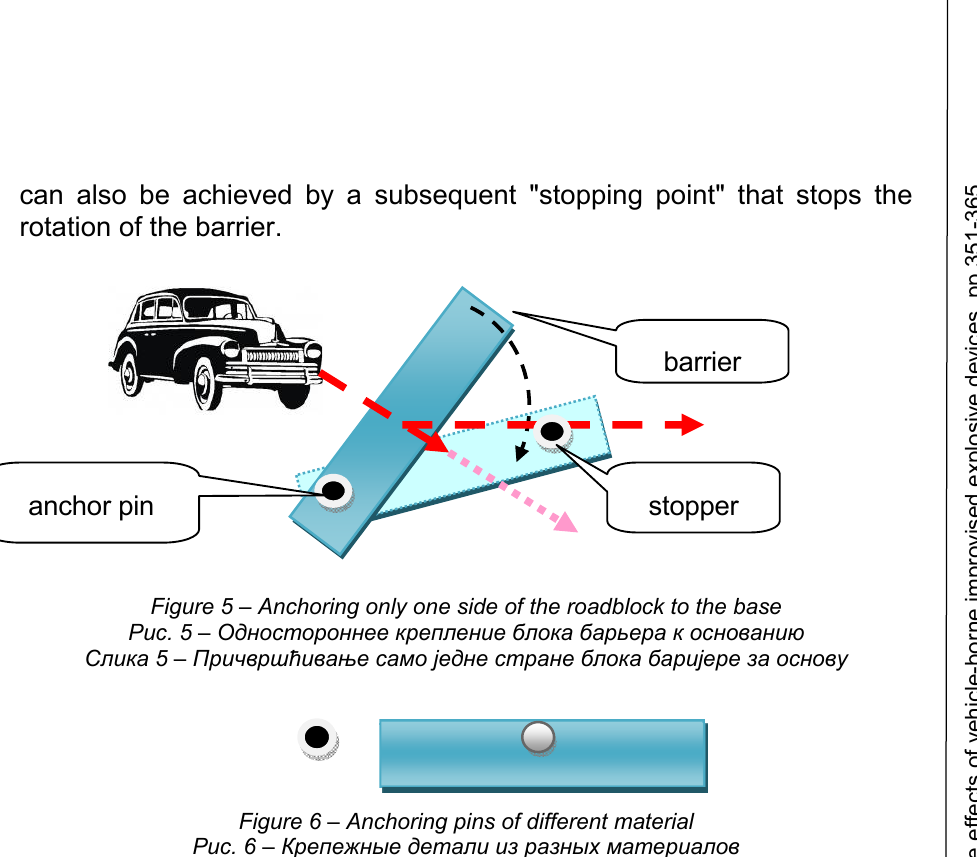
Figure 6 – Anchoring pins of different material Рис . 6 – Крепежные детали из разных материалов Слика 6 – Елементи за причвршћивање од различитих